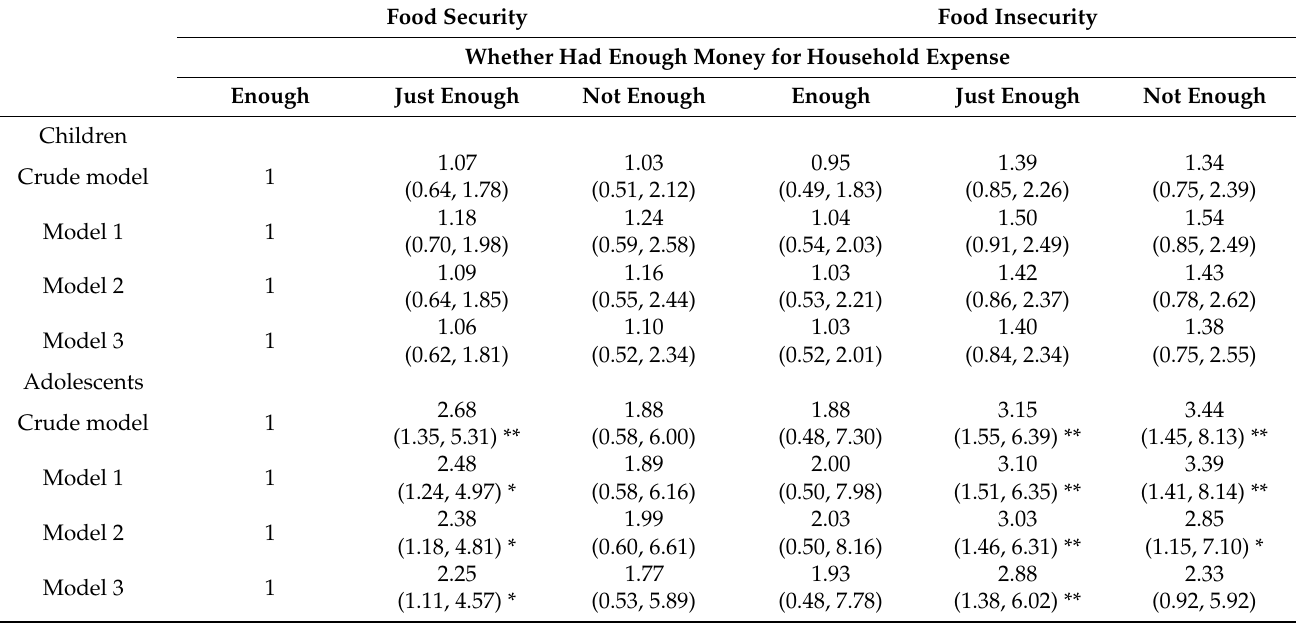
Table 3. Odds ratio (95% CI) of poor dietary quality (DDS < 4) by joint effect of food security and household financial status among children and adolescents. Food Security Food